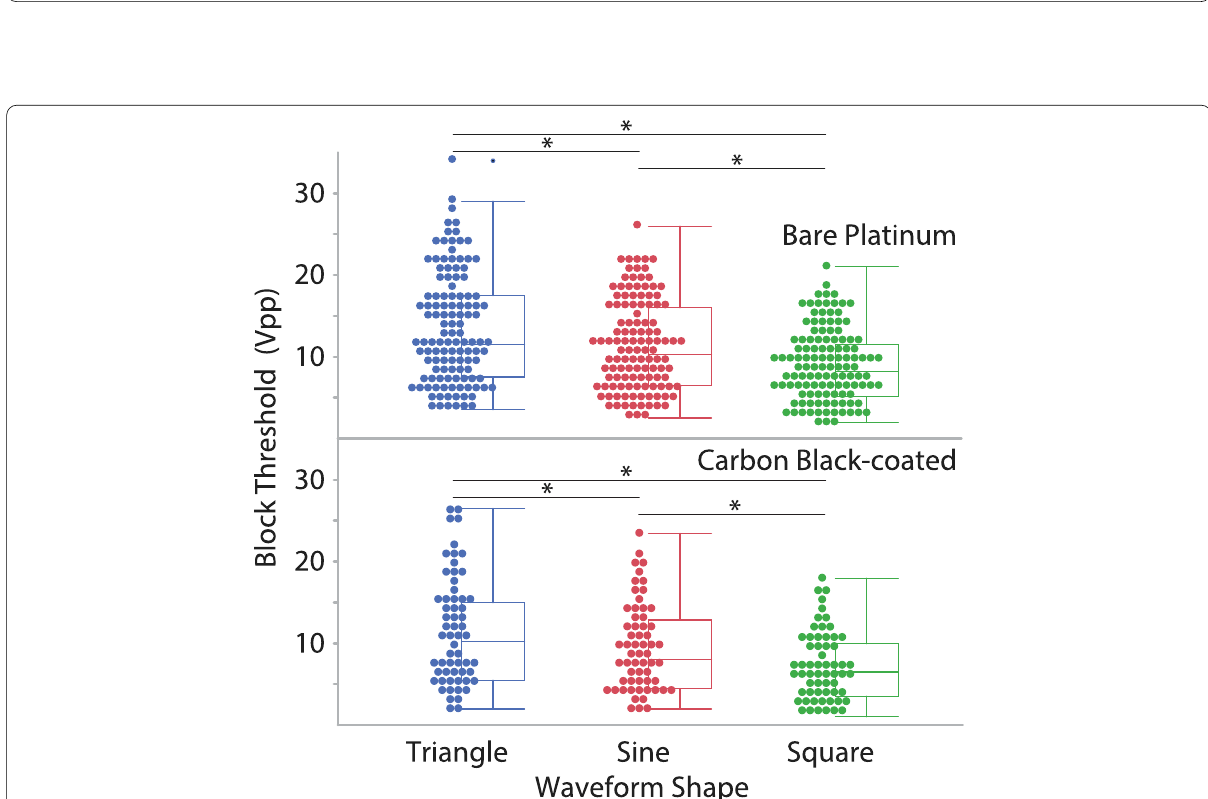
Fig. 7 Block Thresholds for each waveform shape. Box plot showing block thresholds for the three waveform shapes. There are significant differences between each waveform shape (* p <